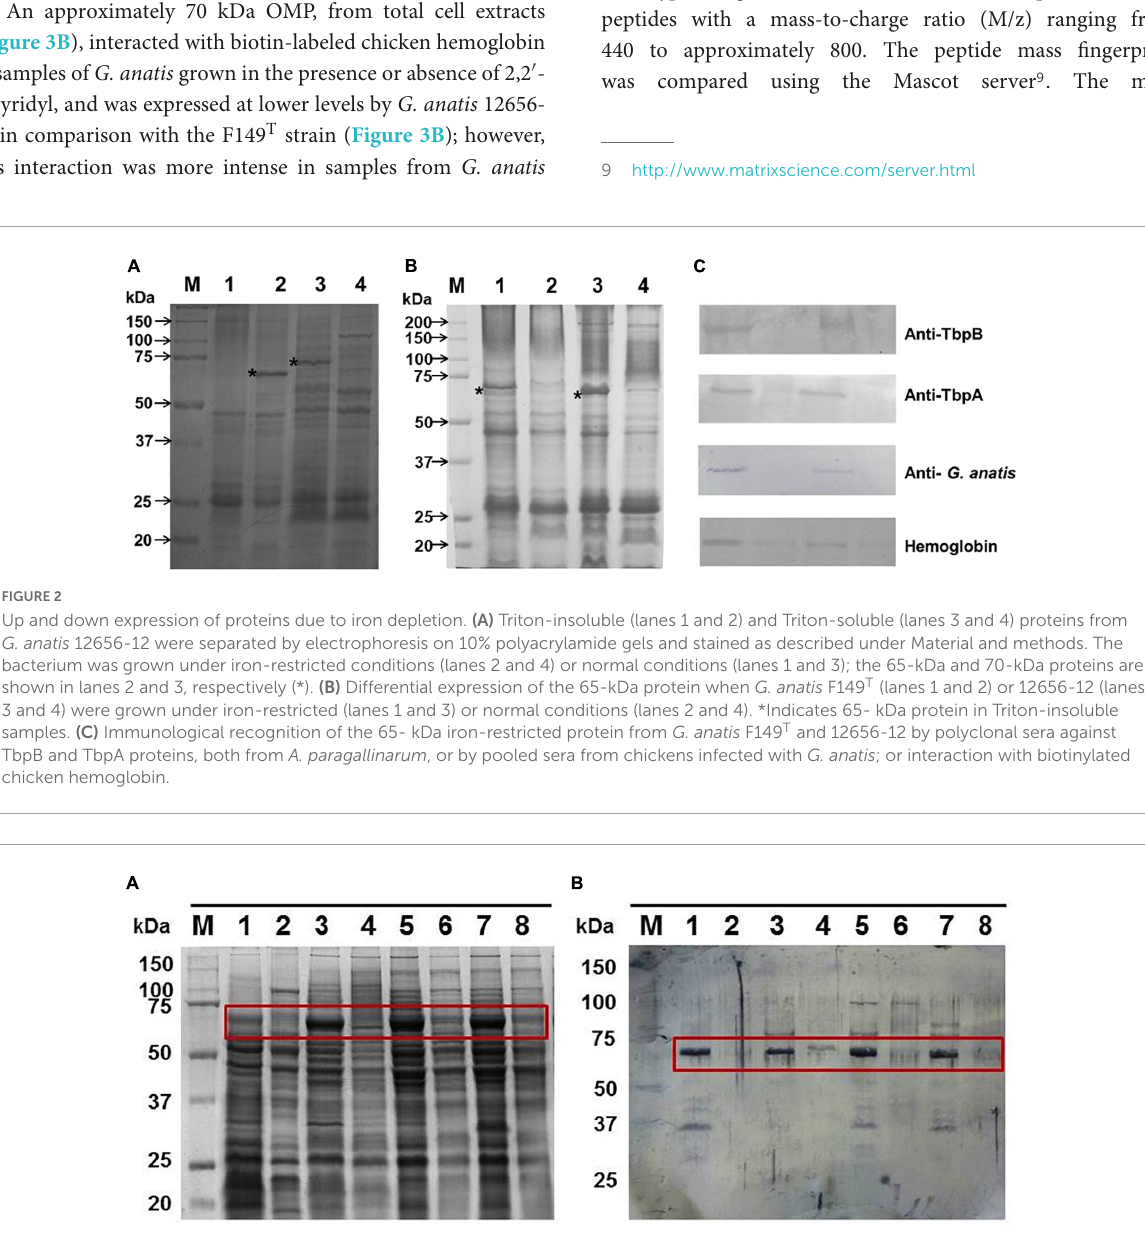
FIGURE3 (A) Total cell extracts protein pattern in a 10% polyacrylamide gel from different G. anatis grown in normal (lanes 1, 3, 5, and 7) or iron-restricted conditions (lanes 2, 4, 6, and 8) of the 12566-12, F149 T , F114, and ESV34 strains, respectively. The rectangle indicates the hemoglobin-binding protein. Twenty-five micrograms were loaded per well. (B) Interaction of proteins with biotinylated chicken